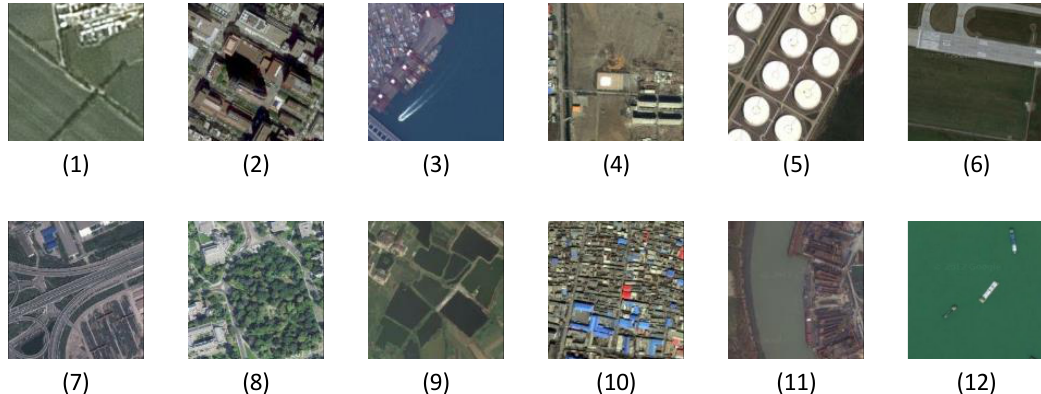
Figure 14. Representation of classes in the SIRI-WHU dataset. (1) Agriculture. (2) Commercial. (3)